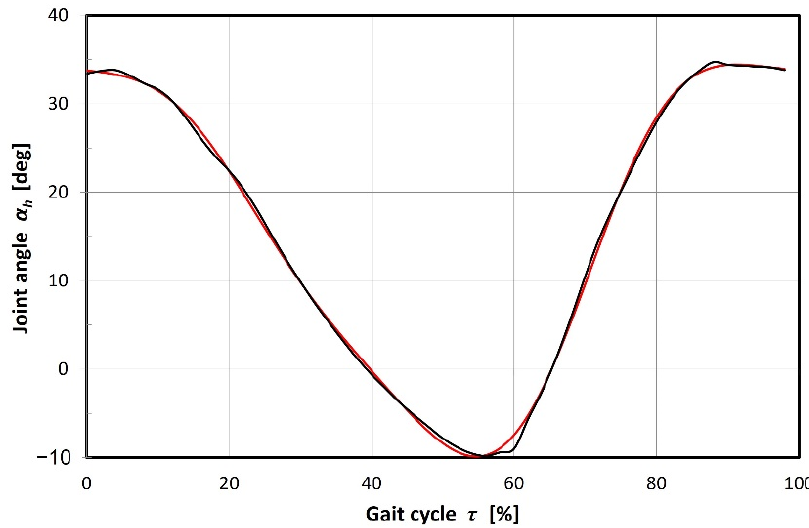
Figure 4. An example of the course of the hip bend angle in the gait cycle of a healthy person: black line—measurement data; red line—approximation for control needs.